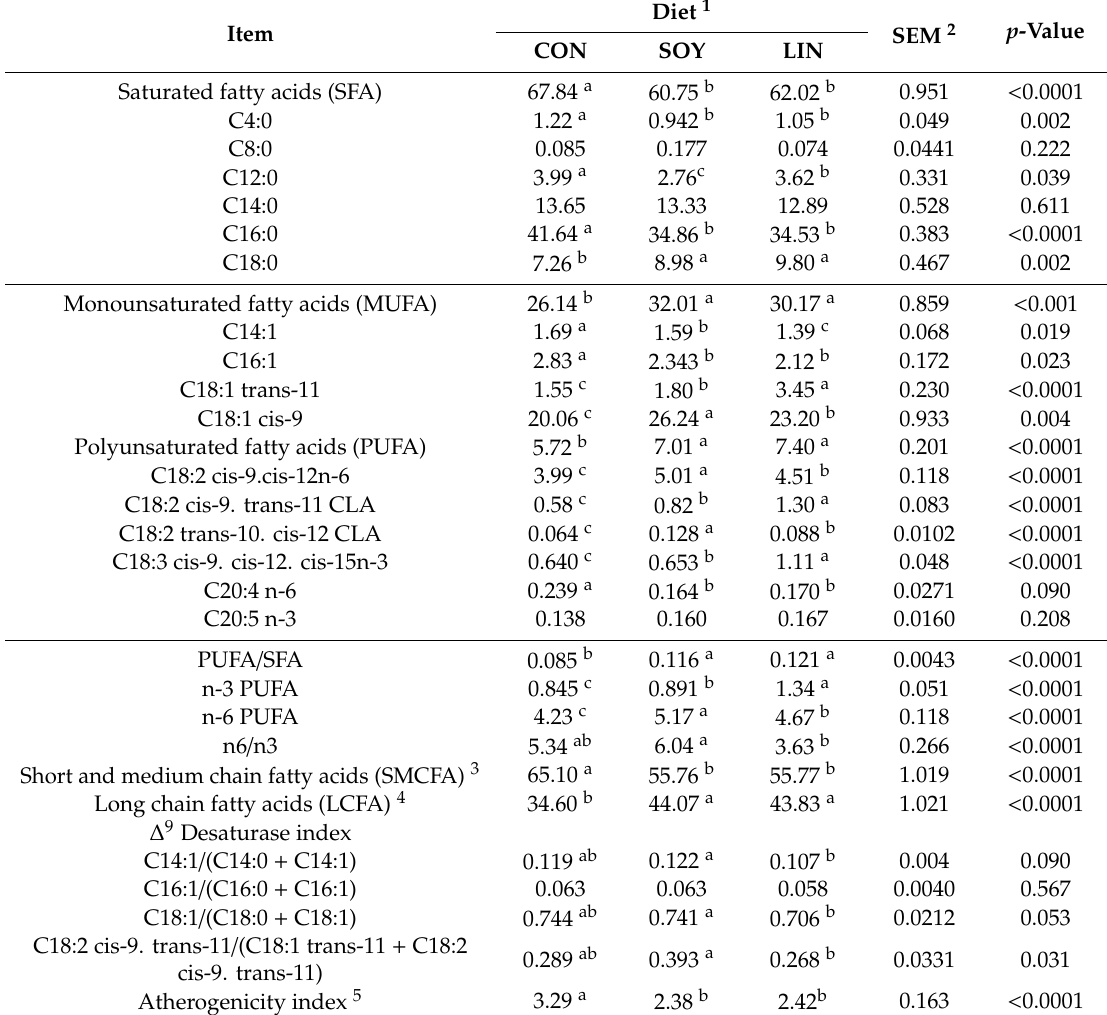
Table 4. Fatty acids composition of milk (g / 100 g total fatty